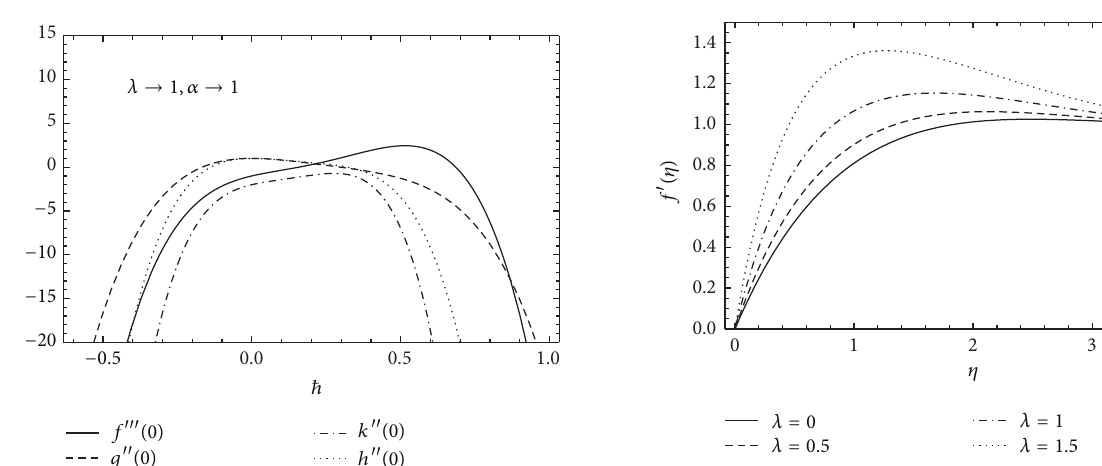
Figure 2: The ℏ curves for 𝑓 󸀠󸀠󸀠 (0) , 𝑔 󸀠󸀠 (0) , 𝑘 󸀠󸀠 (0) , and ℎ 󸀠󸀠 (0) .